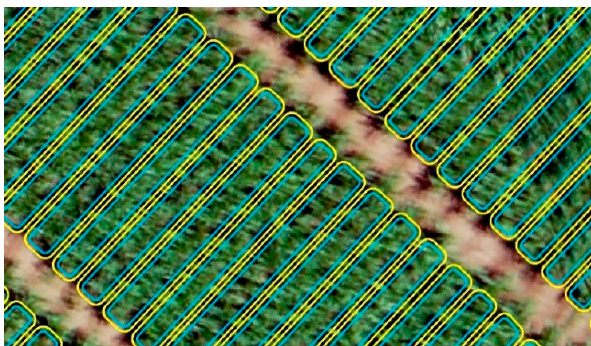
Figure 8. Plot boundaries (yellow lines) and buffered boundaries (blue lines) overlaid on an orthomosaic.